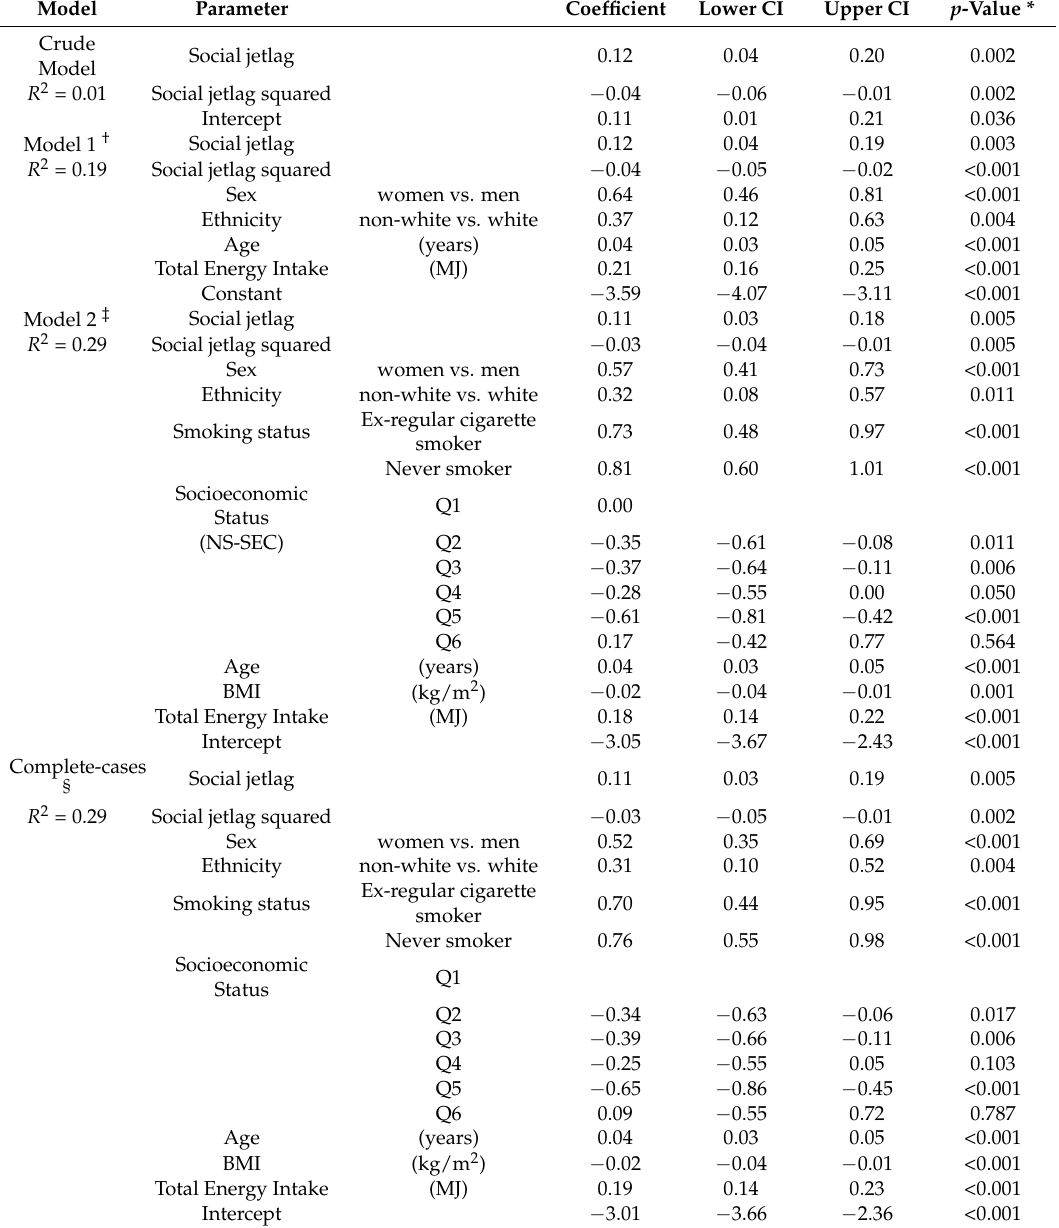
Table 4. Coefficient estimates from the multiple regression models of the association between social jetlag and healthy dietary pattern as the outcome.